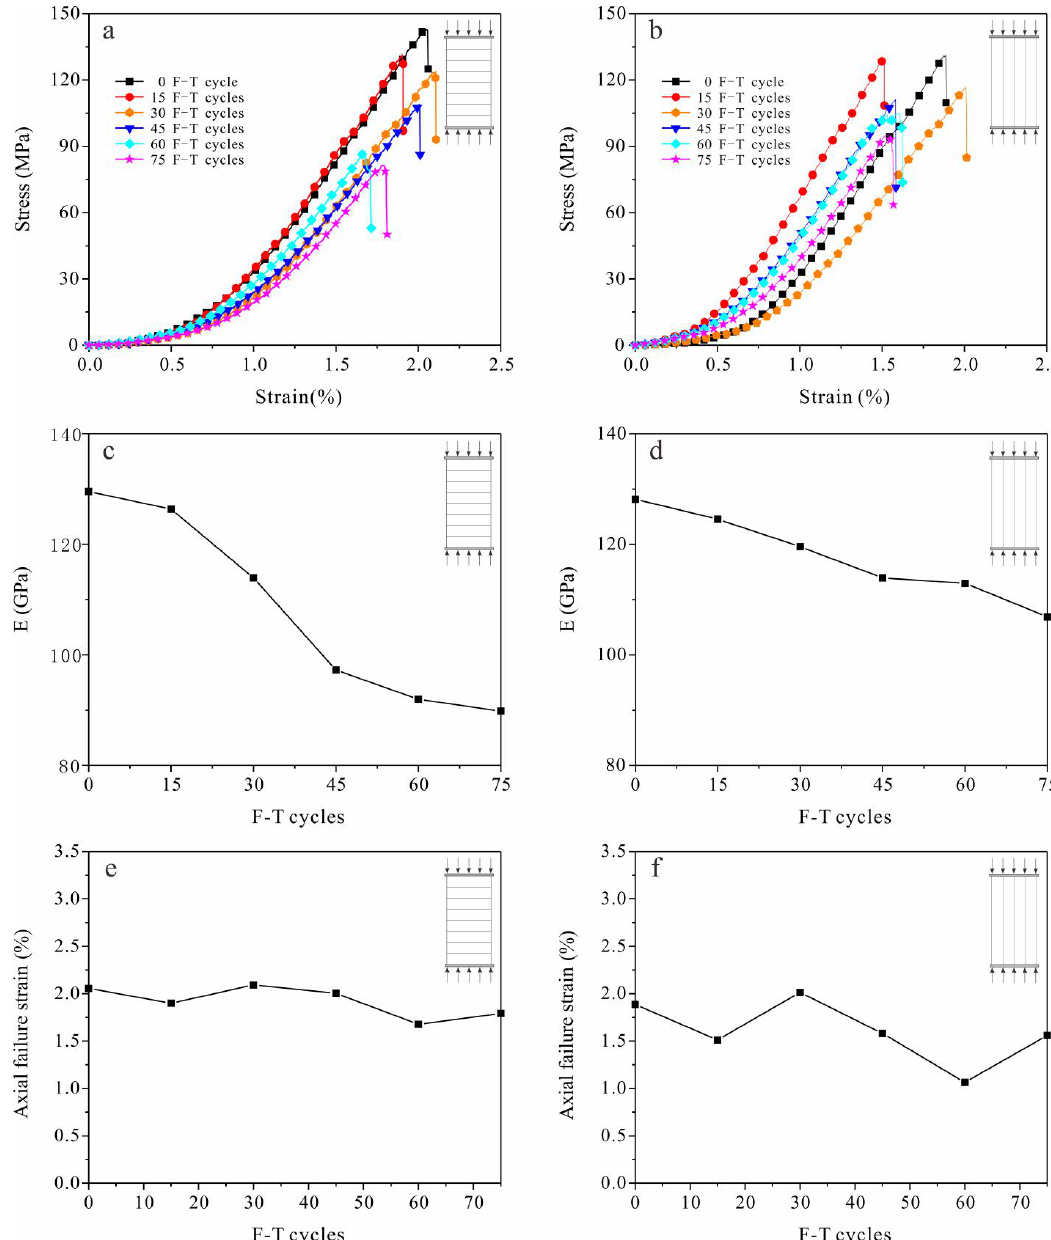
Figure 4. Curves of stress–strain (top), elastic modulus (middle) and axial failure strain (bottom) with F-T cycles of sandstone samples with loading ( a , c , e ) perpendicular (S per ) and ( b , d , f ) parallel (S par ) to the bedding direction.